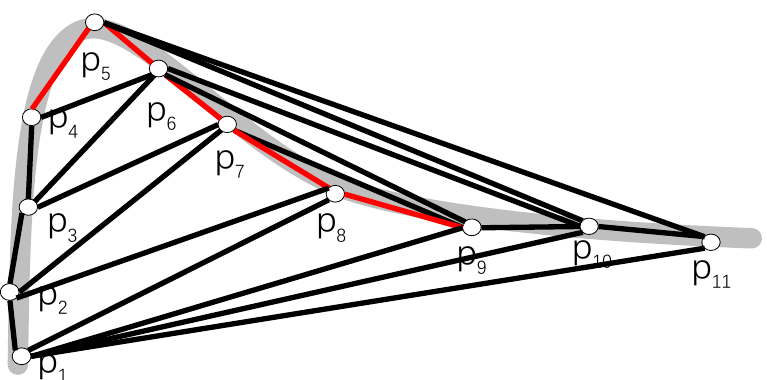
Figure 10. Interpolation result with the weight of the α power ( α = 2) of the edge length. According to the above interpolation algorithm, we interpolate all the connecting segments depicted in Figure 7 and get the road network graph as depicted in Figure 11. The representative points in Figure 11 are connected in order along the road. Each connecting segment is mapped to a Delaunay edge. Then, a figure with a height similar to the road shape is obtained.